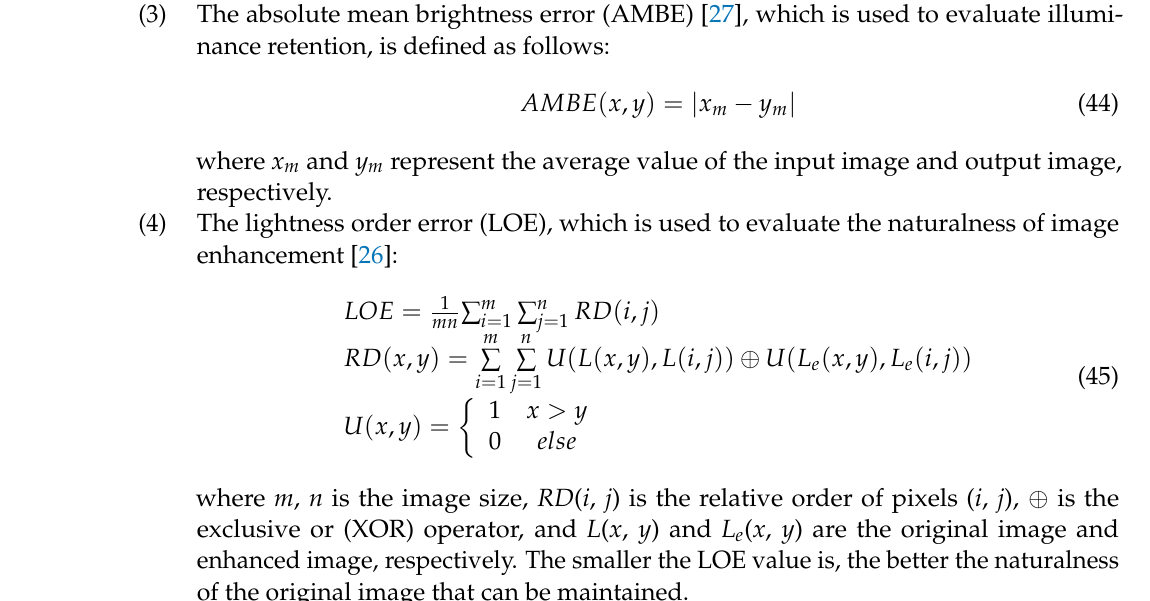
Figure 11. Histogram analysis: ( a ) i mages from Figure 10a–c; ( b ) images in Figure 10d–f.